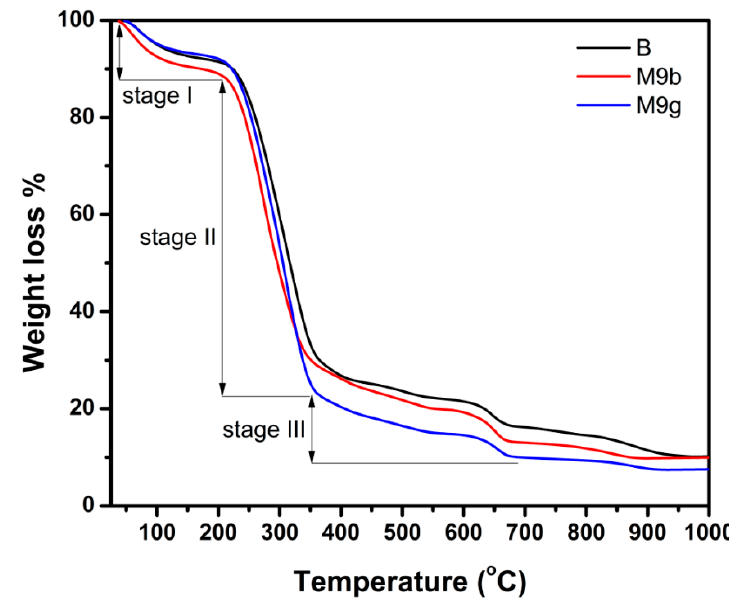
Figure 7. Thermal gravimetric analysis ( TGA ) analysis of B , M9b and M9g